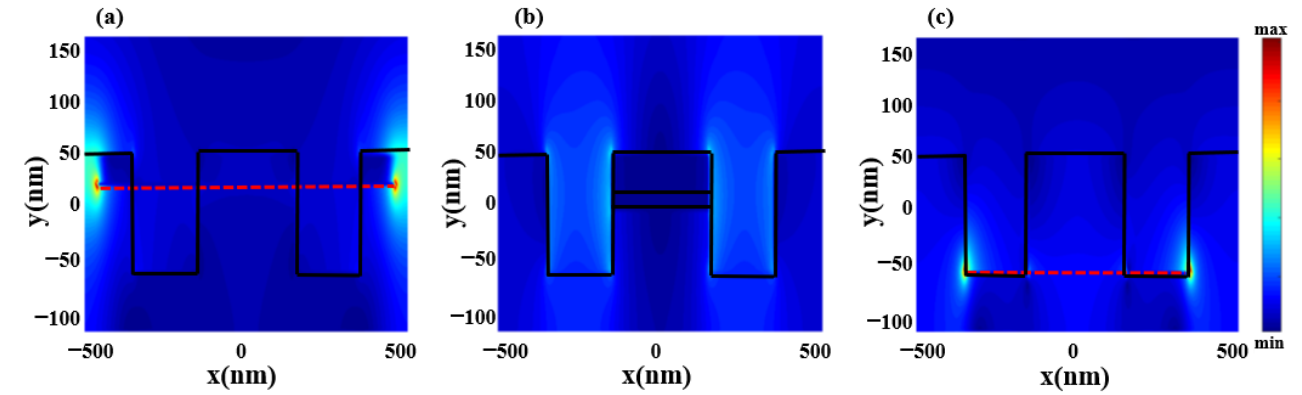
Figure 3. Distribution of the electric field when two layers of graphene and a thin layer of gold are present separately for this structure. ( a ) Upper layer graphene at resonant frequency. ( b ) Mid-layer of gold without resonance. ( c ) Lower layer graphene at the resonant frequency.